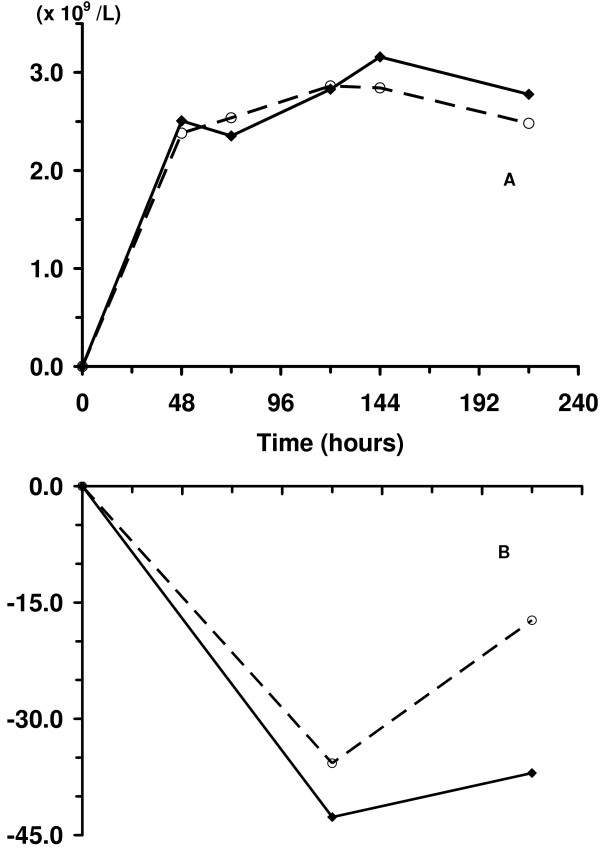
Pharmacodynamic variables. Data correspond to patients who received 100 IU/Kg of Heberitro (solid line) or Eprex (dashed line). (A): average reticulocyte counts increments; (B): percentage mean reduction in serum iron. Standard deviations are not shown for the sake of simplicity of the illustration.